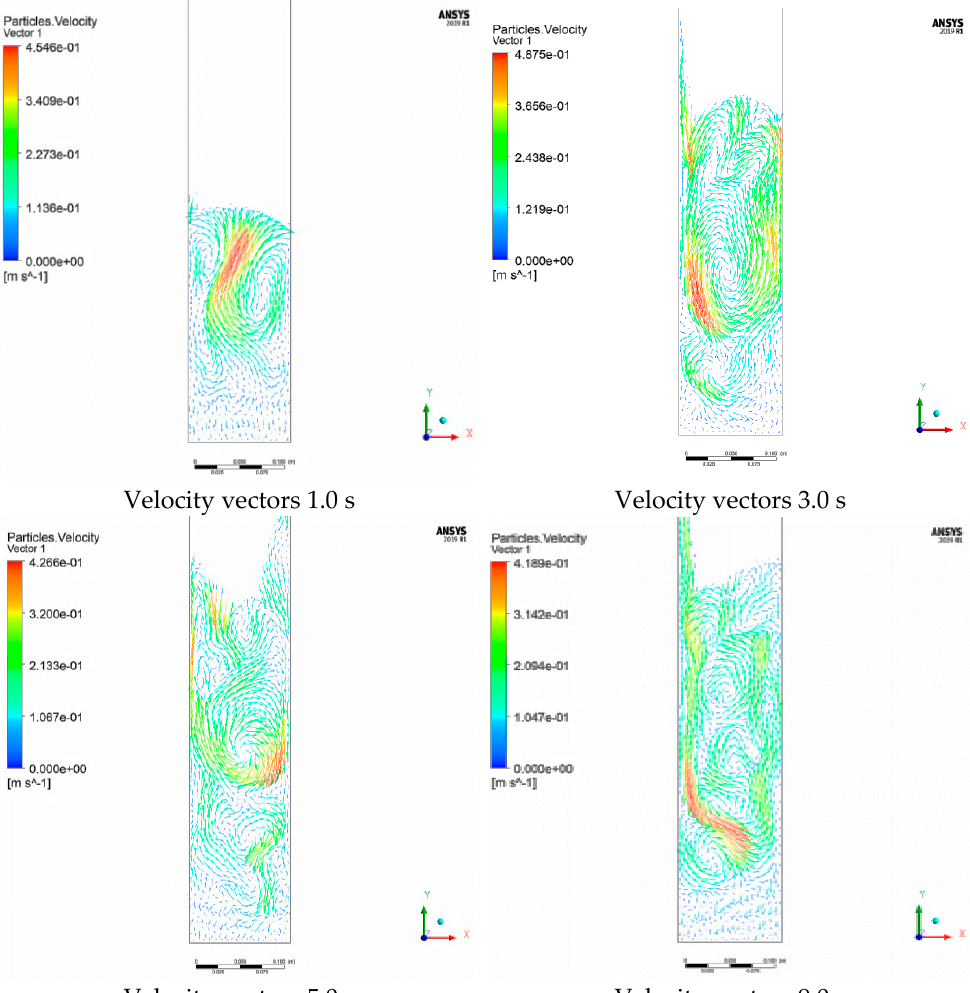
Figure 17. The velocity vectors of particles diameter of 4 mm with time.